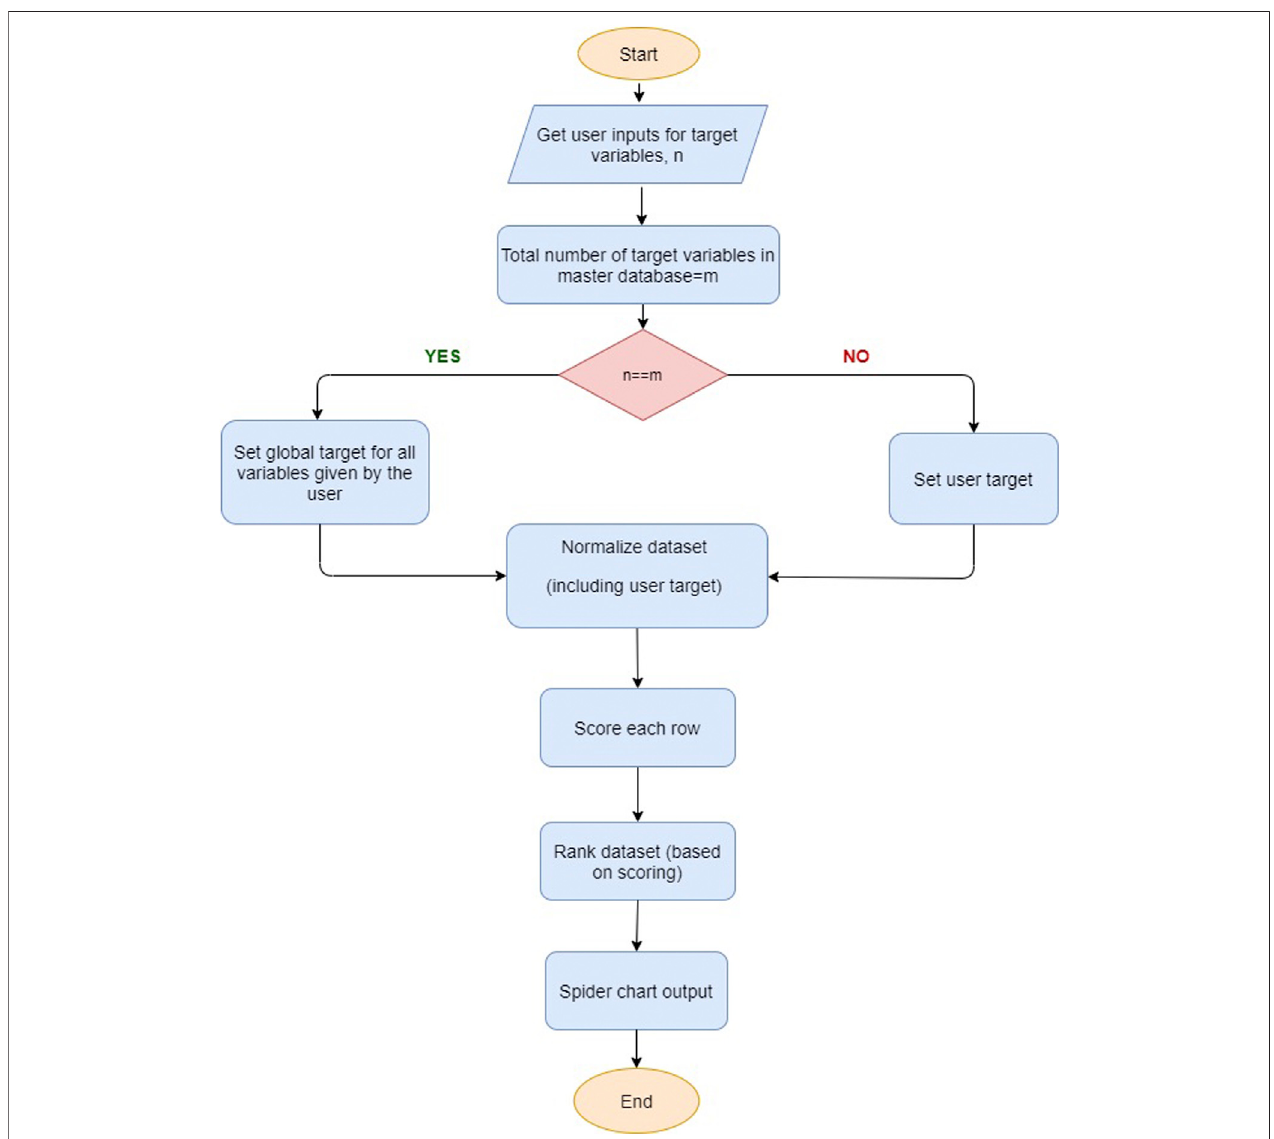
FIGURE 2 | Flowchart of material identi fi cation